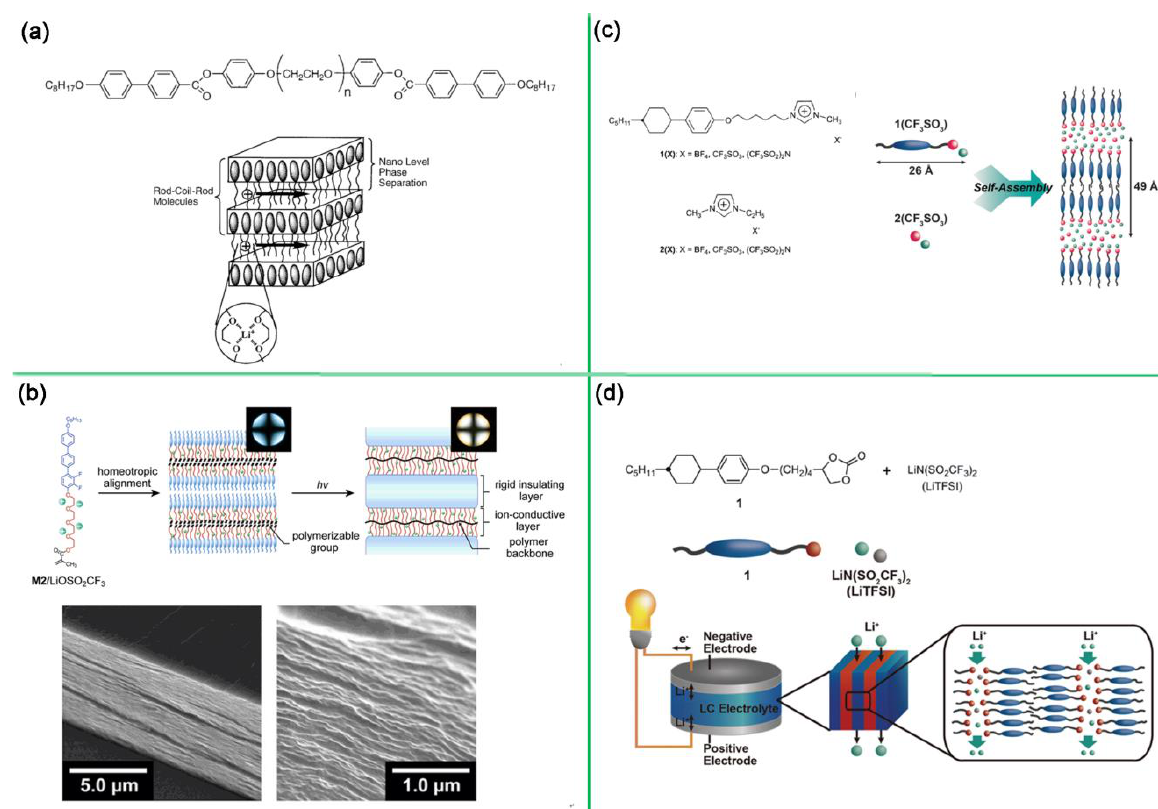
Figure 2. ( a ) Molecular structure of LC-based polymer and ion conduction model. Reproduced with permission [35]. Copyright 2000, American Chemical Society. ( b ) The preparation route of the polymer electrolyte and corresponding SEM images of the electrolyte film. Reproduced with permission [36]. Copyright 2005, American Chemical Society. ( c ) Schematic illustration of the self-assembled structure based on ionic liquid crystals 1(X) and ionic liquids 2(X). Reproduced with permission [37]. Copyright 2015, Royal Society of Chemistry. ( d ) Schematic illustration of the concept and design for LIBs containing the LC electrolyte. Reproduced with permission [33]. Copyright 2015, Wiley-VCH.